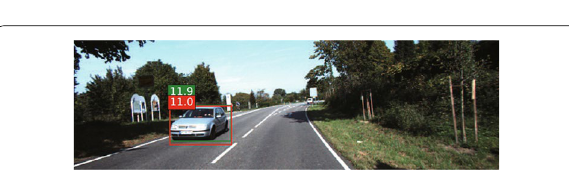
Fig. 3 Examples of the relation between the appearance of target objects (cars), and those distance in KITTI dataset. The green and red rectangles are the ground truth and estimated bounding boxes (by our proposed method) respectively. The values in green and red boxes are the GT and estimated distances respectively in a meter. The distance of the car on the left-hand side is 11.9